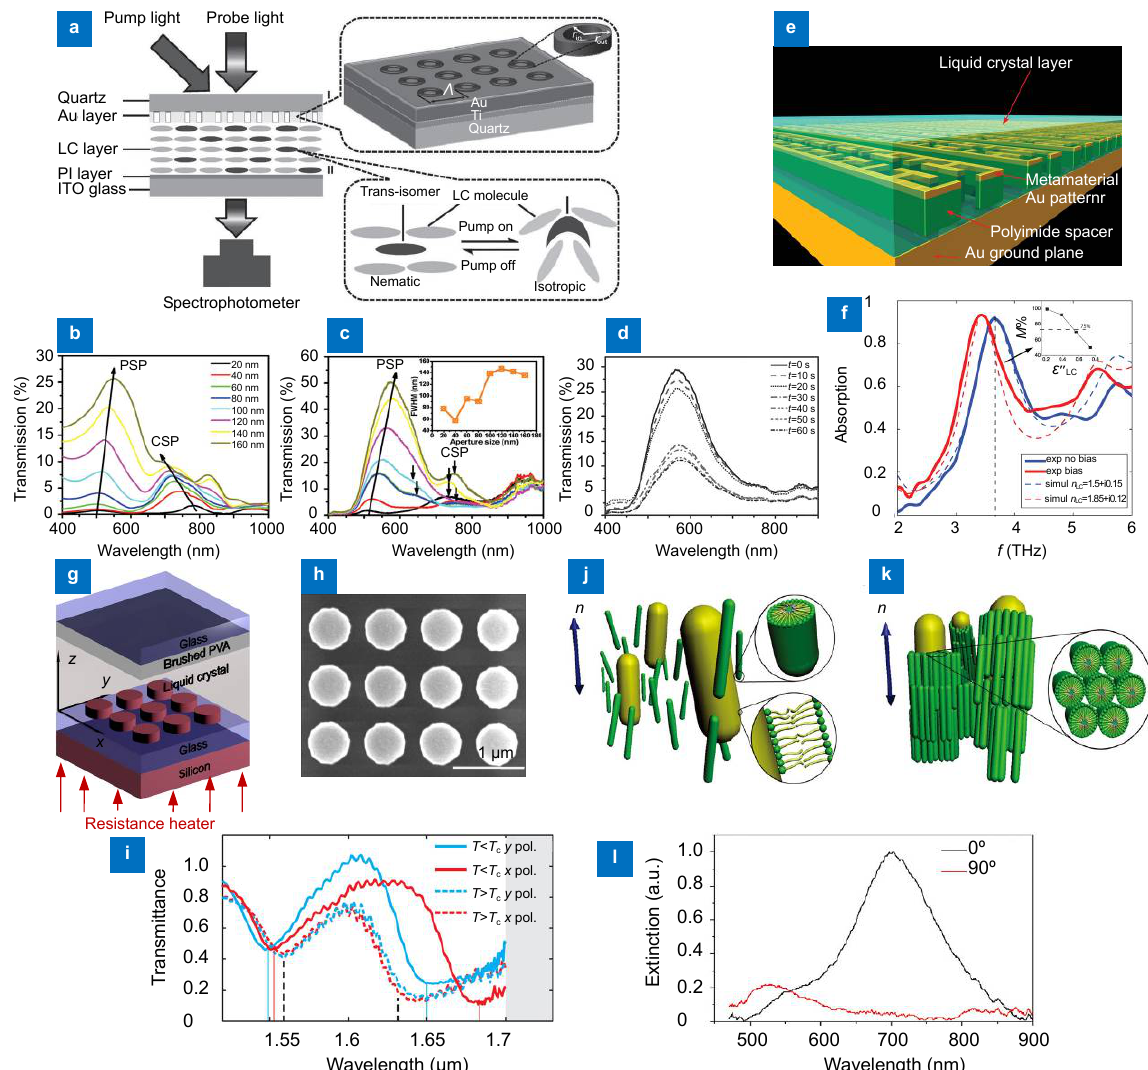
Fig. 12 | Tunable metamaterials using LCs as the active material . ( a ) Schematic of the sample structure and experimental setup. The inset I shows the fabricated square pattern of gold AAAs. The inset II shows the working mechanism of the optical driving process. The ( b ) theoretically calculated and ( c ) experimentally measured transmission spectra of color filters with different aperture sizes. The inset in ( c ) shows the measured FWHM of corresponding transmission peaks. ( d ) The evolution of the transmission spectra as a function of time under the UV pump for the color filter with an aperture size of 120 nm. ( e ) Schematic view of metamaterial absorber array covered with LC designed for the experiment. ( f ) Comparison of the measured frequency-dependent absorptivities ( A =1 − R ) in the biased (red continuous line) and unbiased conditions (blue continuous line) with those from numerical calculations (dashed lines). The inset shows the calculated percentage modulation factor as a function of the liquid crystal losses. ( g ) Schematic view of the silicon nanodisk metasurface integrated into an LC cell. The silicon nanodisk sample is immersed in the LC, and the cell is covered by a layer of brushed PVA for alignment of the LC. A resistor heater is mounted on the backside of the silicon wafer. ( h ) Scanning electron micrograph of the silicon nanodisk metasurface. ( i ) Measured normalized transmittance spectra. ( j ) Schematic illustration of gold nanorods alignment in the nematic LC and ( k ) gold nanorods alignment in a columnar hexagonal lyotropic LC phase. ( l ) Experimental extinction spectra of gold nanorods in a nematic LC realigned by a magnetic field. Figure reproduced from: ( a – d ) ref. 101 , John Wiley and Sons; ( e , f ) ref. 108 , John Wiley and Sons; ( g – i ) ref. 109 , American Chemical Society; ( j – l ) ref. 67 , American Chemical